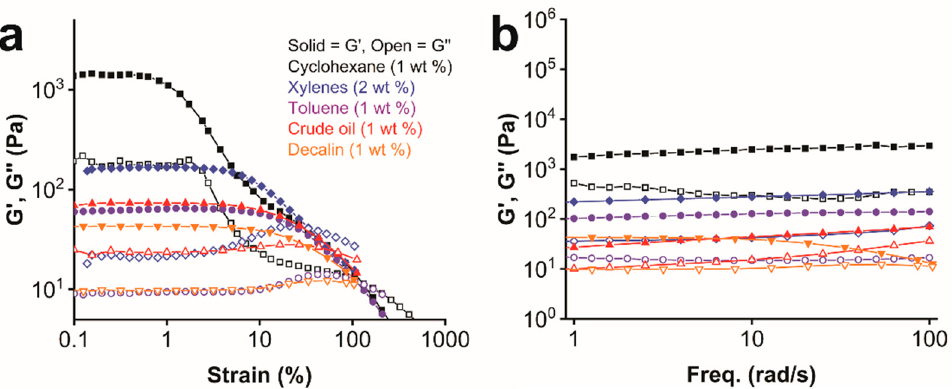
Figure 5. Viscoelastic response of the organogels of ISA24 with different organic liquids. ( a ) Strain sweep. ( b ) Frequency sweep.